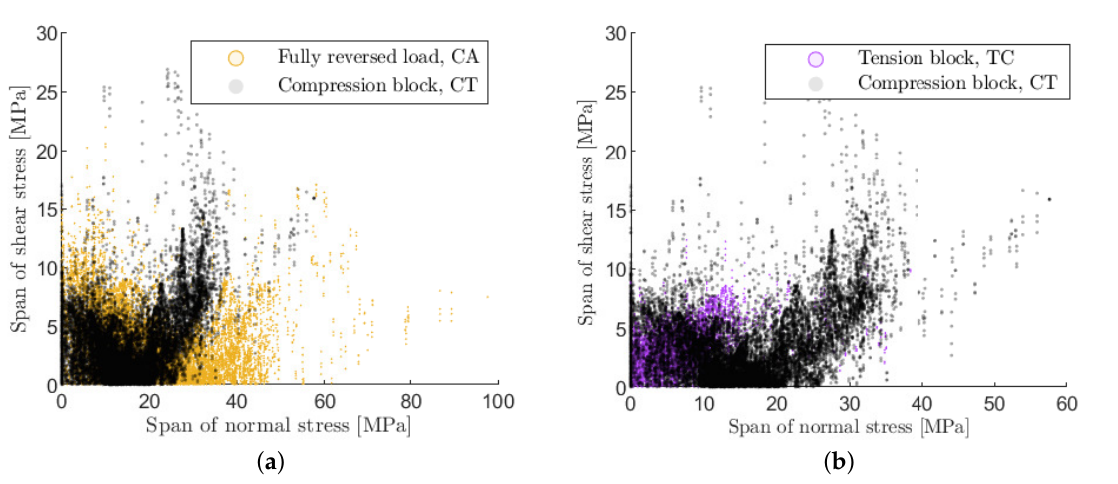
Figure 10. ( a ) Comparison of the stress span within a fully reversed cycle (CA) and within a compression block (CT) ( b ) comparison of the stress span within a compression block (CT) and within a tension block